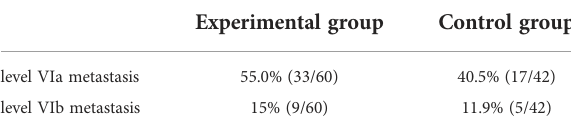
TABLE 5 Level VI lymph node metastasis